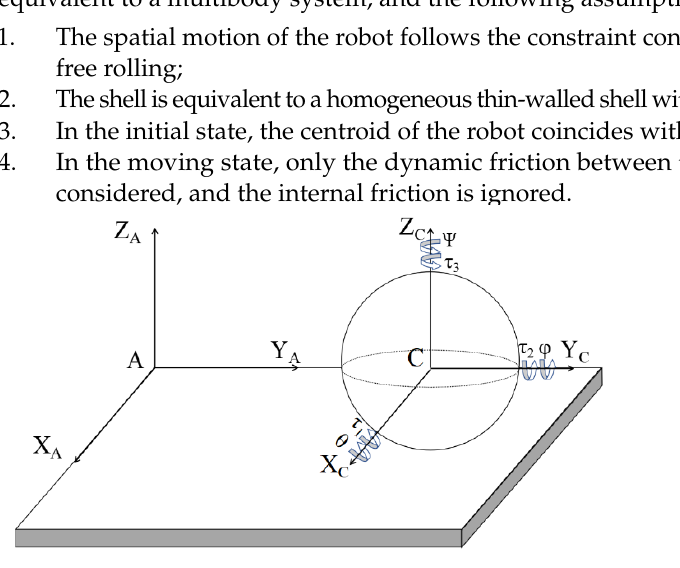
Figure 10. Spatial coordinate